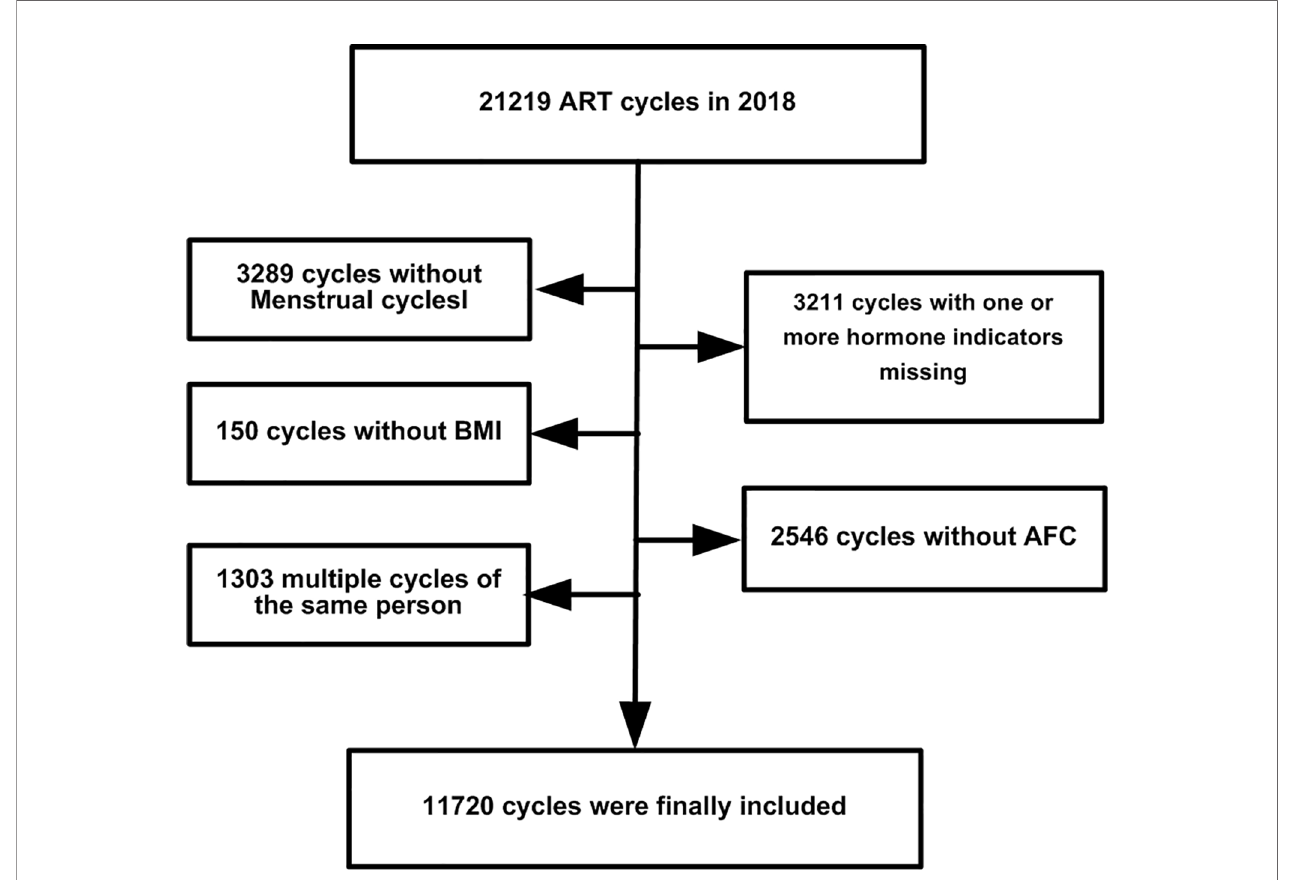
FIGURE 1 | The design of this study.